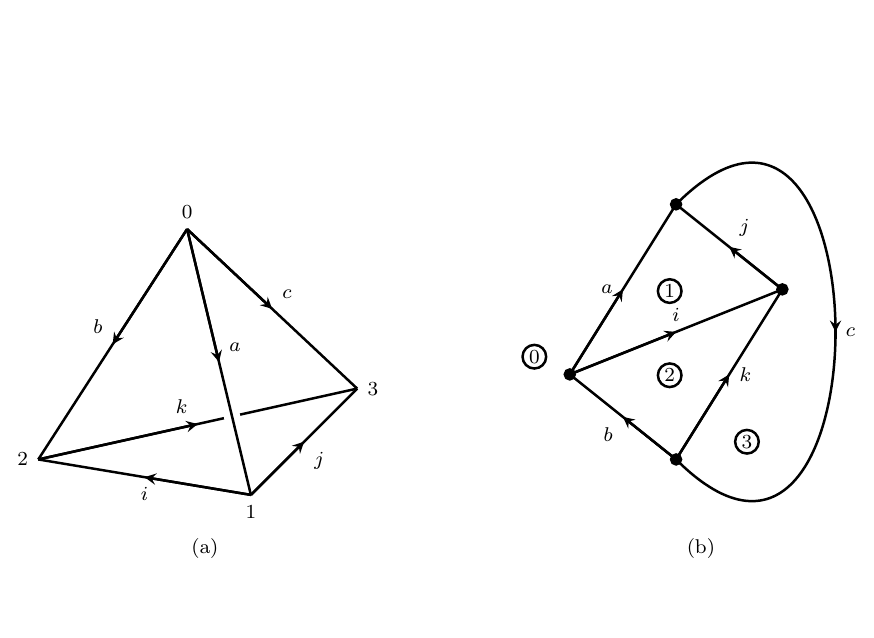
Figure 29 . Left: the basic ingredient of the state sum is a tetrahedron decorated with lines. Right: the dual planar graph in the spherical fusion category. For clarity we denoted with circled numbers the tetrahedron vertices dual to each face.